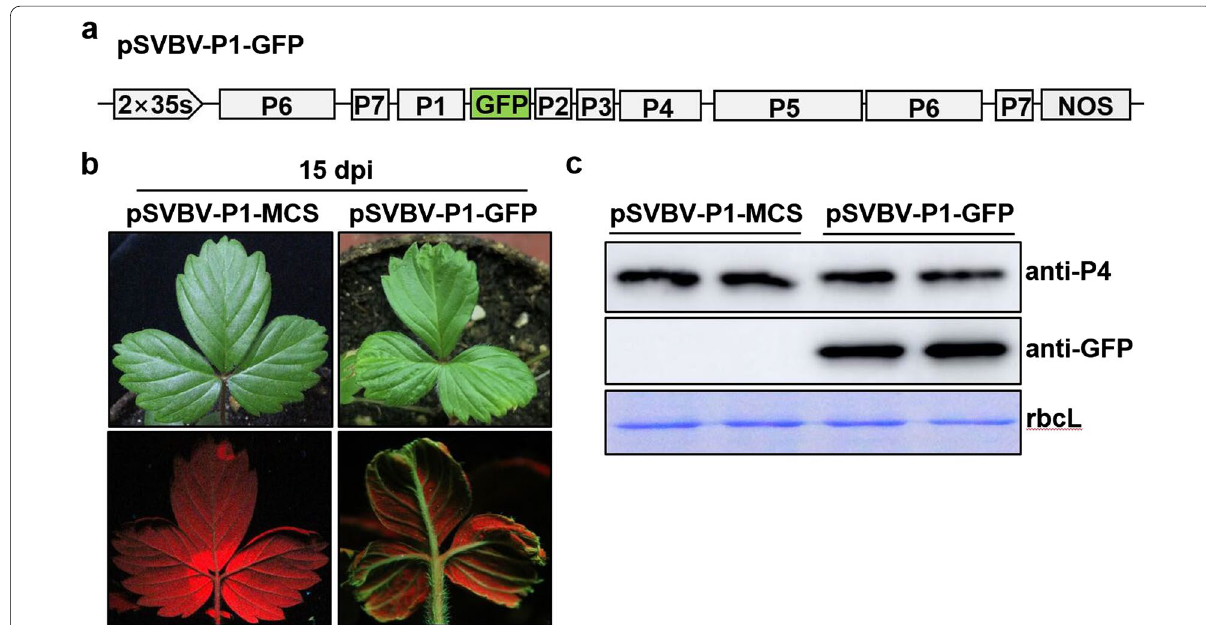
Fig. 2 Expression of GFP in strawberry plants inoculated with the pSVBV-P1-GFP vector. a Schematic representation of the overexpression vector pSVBV-P1-GFP. The GFP gene was cloned into pSVBV-P1-MCS via the Pml I- Bam HI sites. b Detection of fluorescence signals in the leaves of strawberry plants inoculated with pSVBV-P1-MCS or pSVBV-P1-GFP. The back of the strawberry leaves was illuminated under UV-B light. c Western blot analysis of the leaf samples shown in ( b ) using antibodies for SVBV P4 and GFP. Coomassie brilliant blue (CBB)-staining of the RuBisCO large subunit (rbcL) was used as a loading